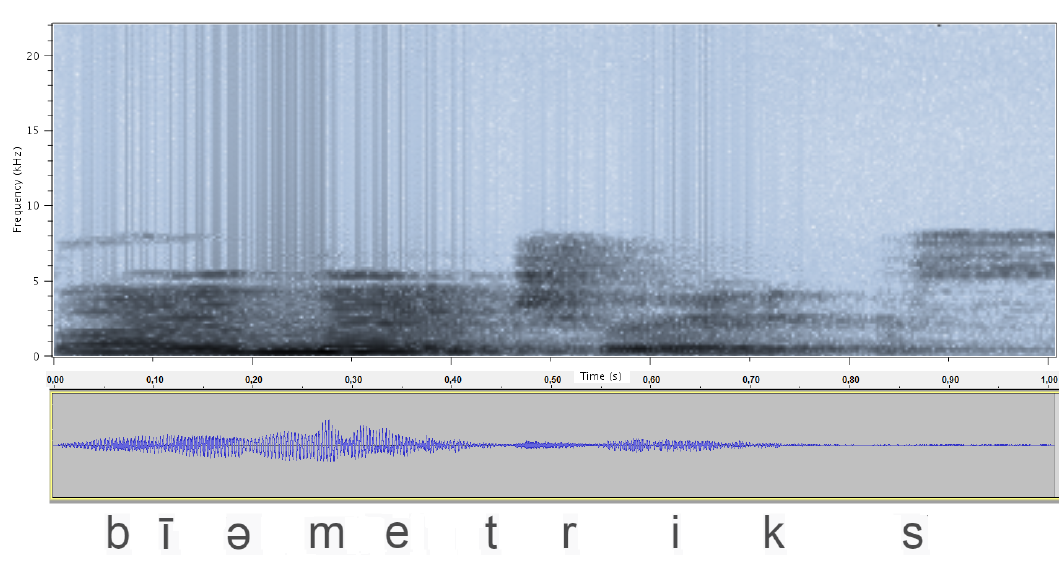
Figure 1. Bottom: Waveform of the sounds of the word “biometrics,” where you can see the consistency in time of each sound that makes it up. Top: Spectrogram of the time-dependent Fourier transform of the